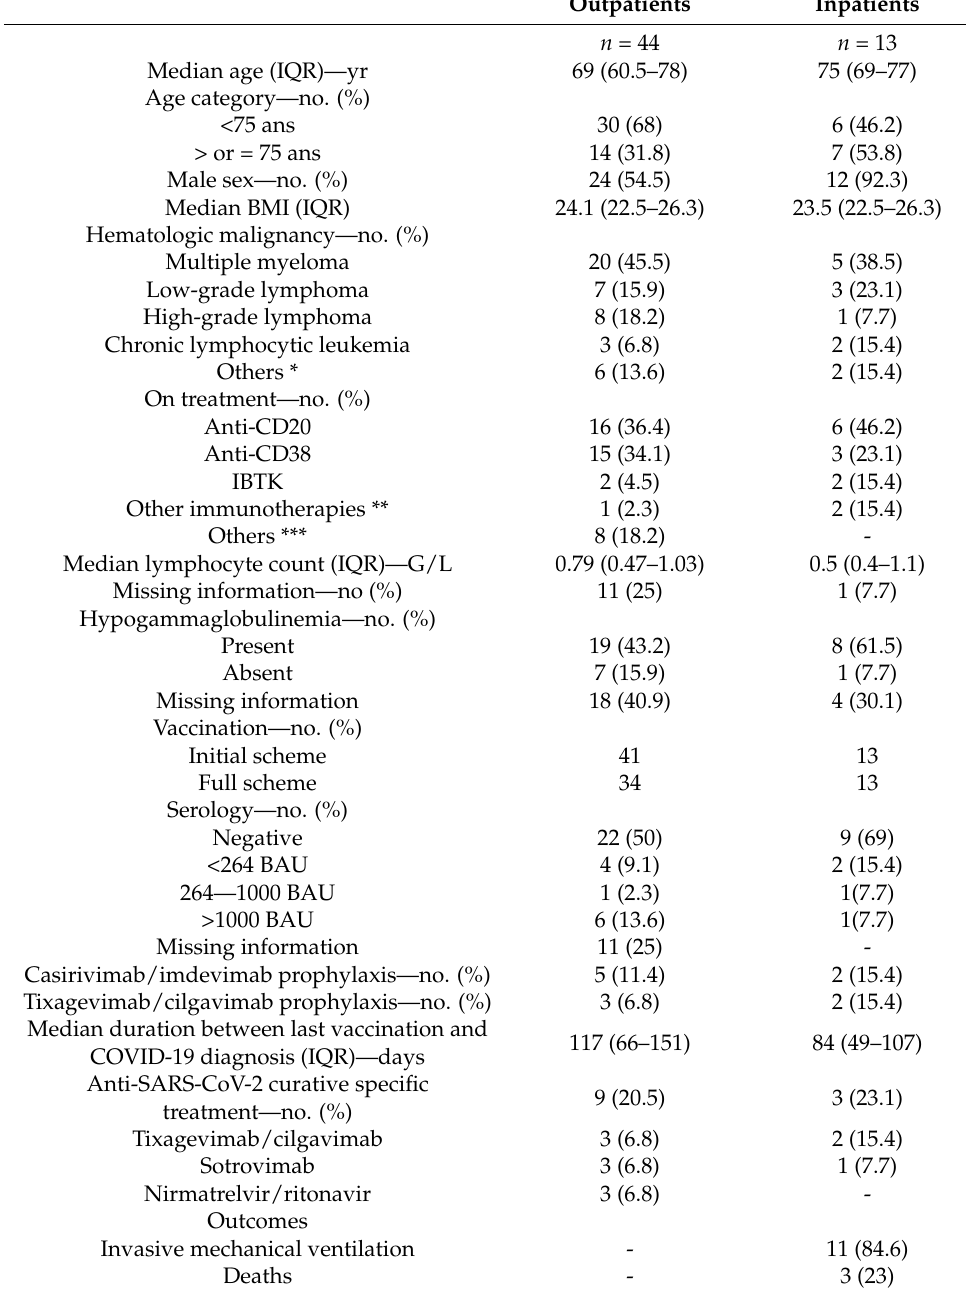
Table 1. COVID-19-positive patients